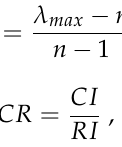
Figure 4. Proposed MatLab algorithm to obtain the priority vector.